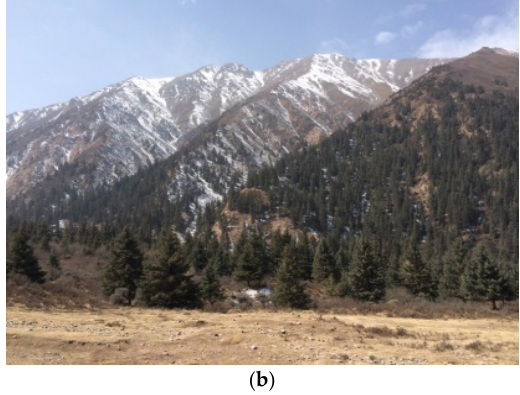
Figure 1. Maps ( a ) and photograph ( b ) of the study area.